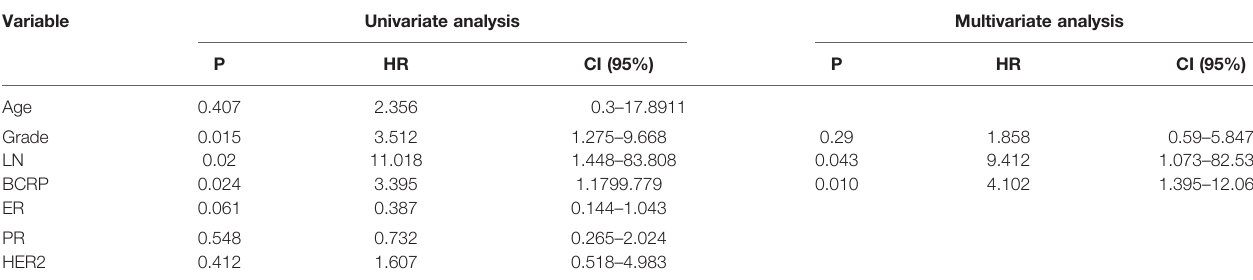
TABLE 2 | Univariate and multivariate analysis for overall survival (Cox proportional hazards regression model).